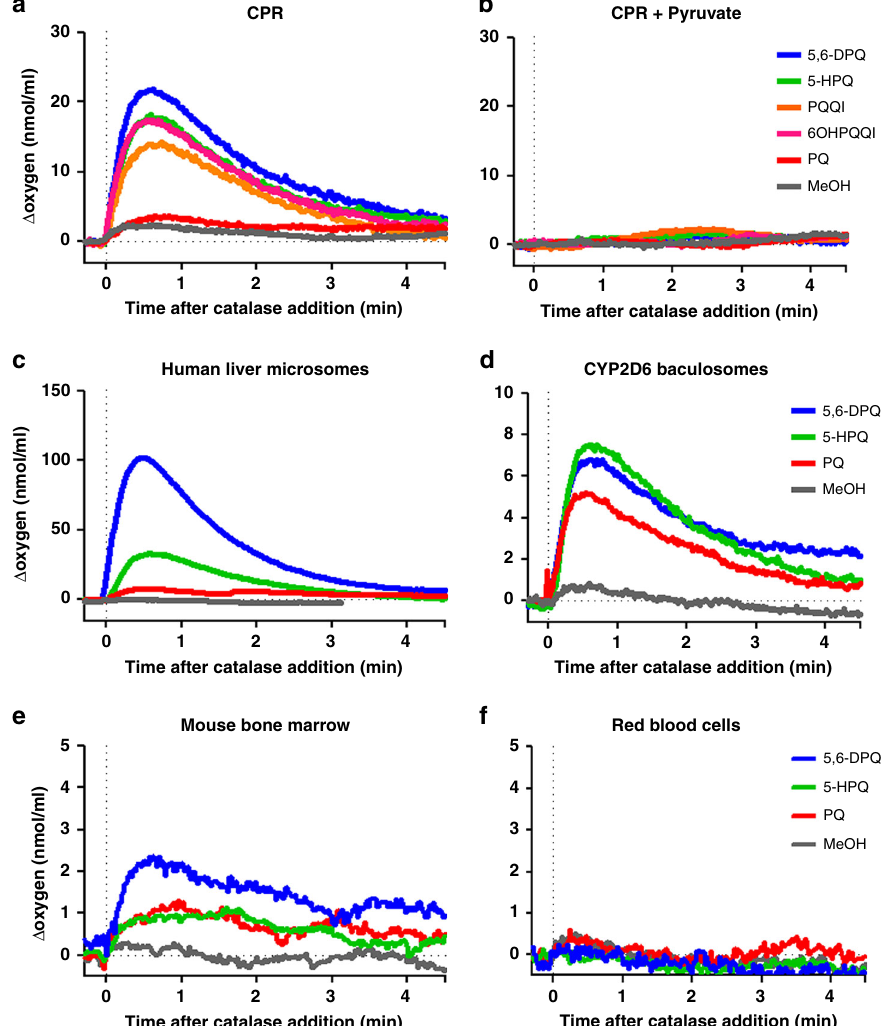
Fig. 2 Metabolism-mediated generation of H 2 O 2 . H 2 O 2 production was measured as catalase-mediated oxygen release after compound incubation (30 μ M) with a human CPR, b human CPR + pyruvate, c human liver microsomes, d CYP2D6-expressing baculosomes, e mouse bone marrow extracts or f red blood cell extracts. The x axis was adjusted by de fi ning the addition of catalase as t = 0, and the corresponding y axis value de fi ned as 0 nmol mL − 1 . The average of two (PQ and 5,6-DPQ) and fi ve (5-HPQ and MeOH) independent measurements are shown NATURE COMMUNICATIONS| (2019) 10:3226